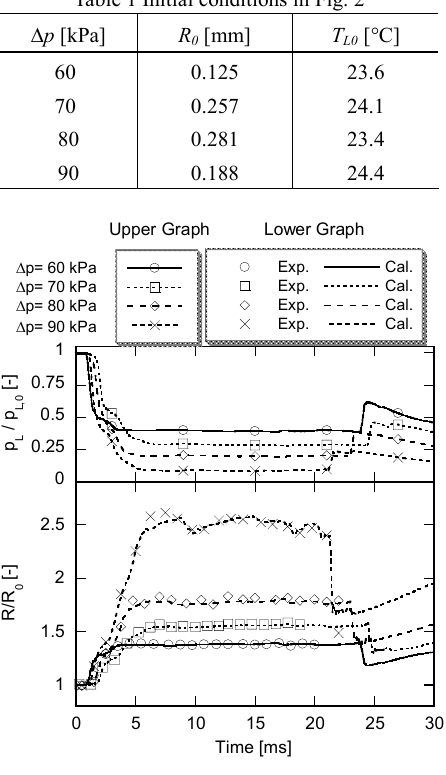
Fig. 2 R - t curves (lower) by experiment and calculation under various pressure drops (upper).